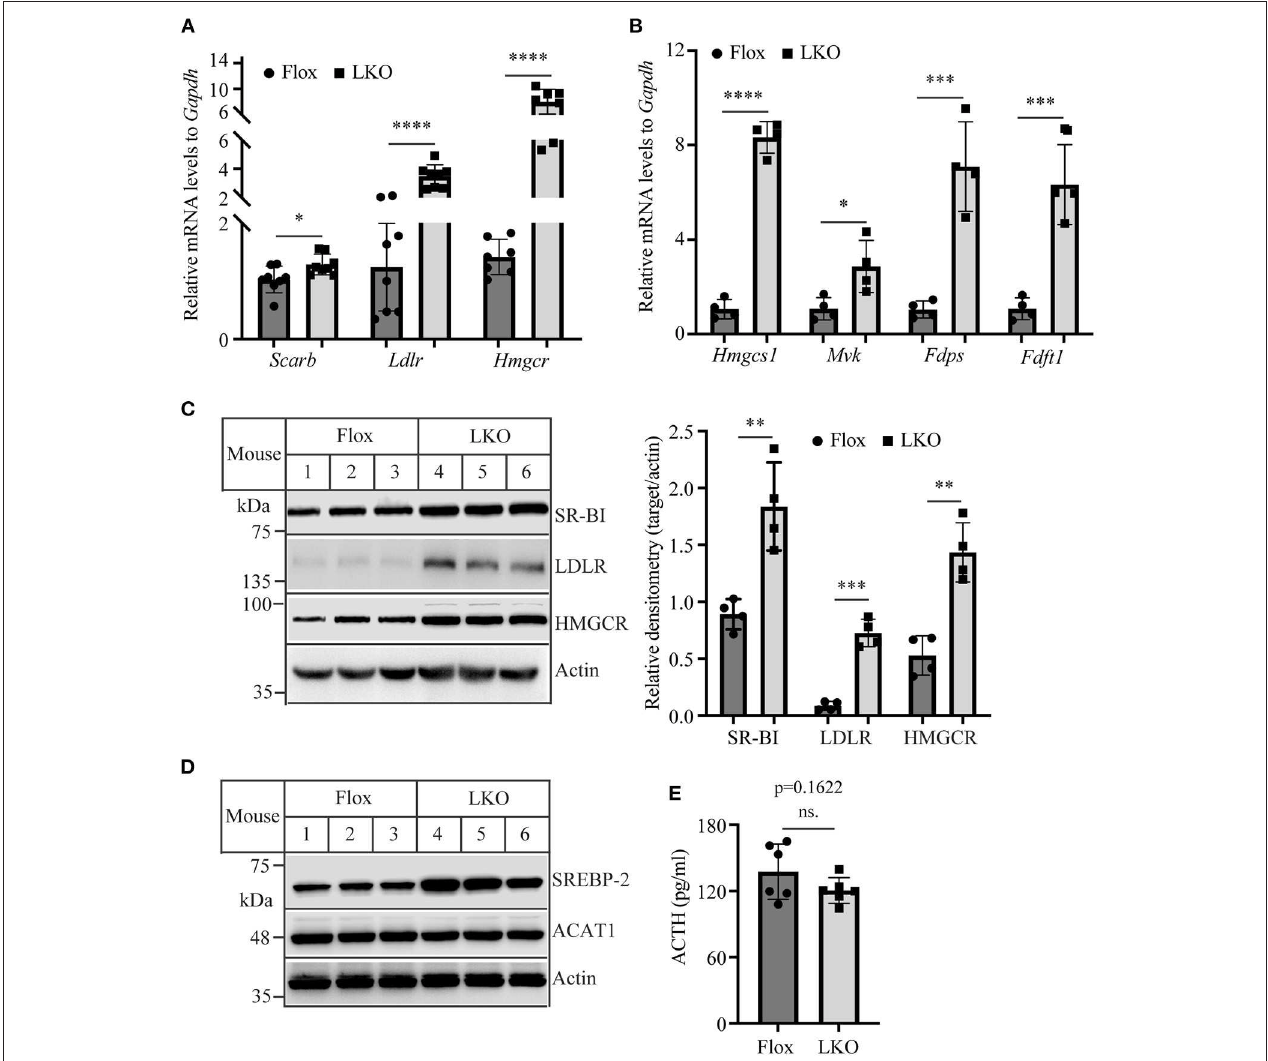
FIGURE 5 | The expression of genes involved in cholesterol metabolism. (A,B) qRT-PCR. The relative mRNA levels were the ratio of the target’s mRNA levels indicated to that of Gapdh at the same condition. (C,D) Immunoblotting. The same amount of adrenal homogenate was applied to Western Blot using antibodies as indicated. Representative figures were shown. The densitometry was assessed. The relative densitometry is the densitometry of each target to that of actin in the same sample (C) . (E) Plasma levels of ACTH. Mice (10–12-week-old, male) were fasted for 12h. Plasma was then collected and subjected to the measurement of ACTH using an ELISA kit. Values of all data were mean ± S.D. The significance was defined as * p < 0.05, ** p < 0.01, *** p < 0.001, and **** p < 0.0001. p > 0.05 was defined as no significant difference